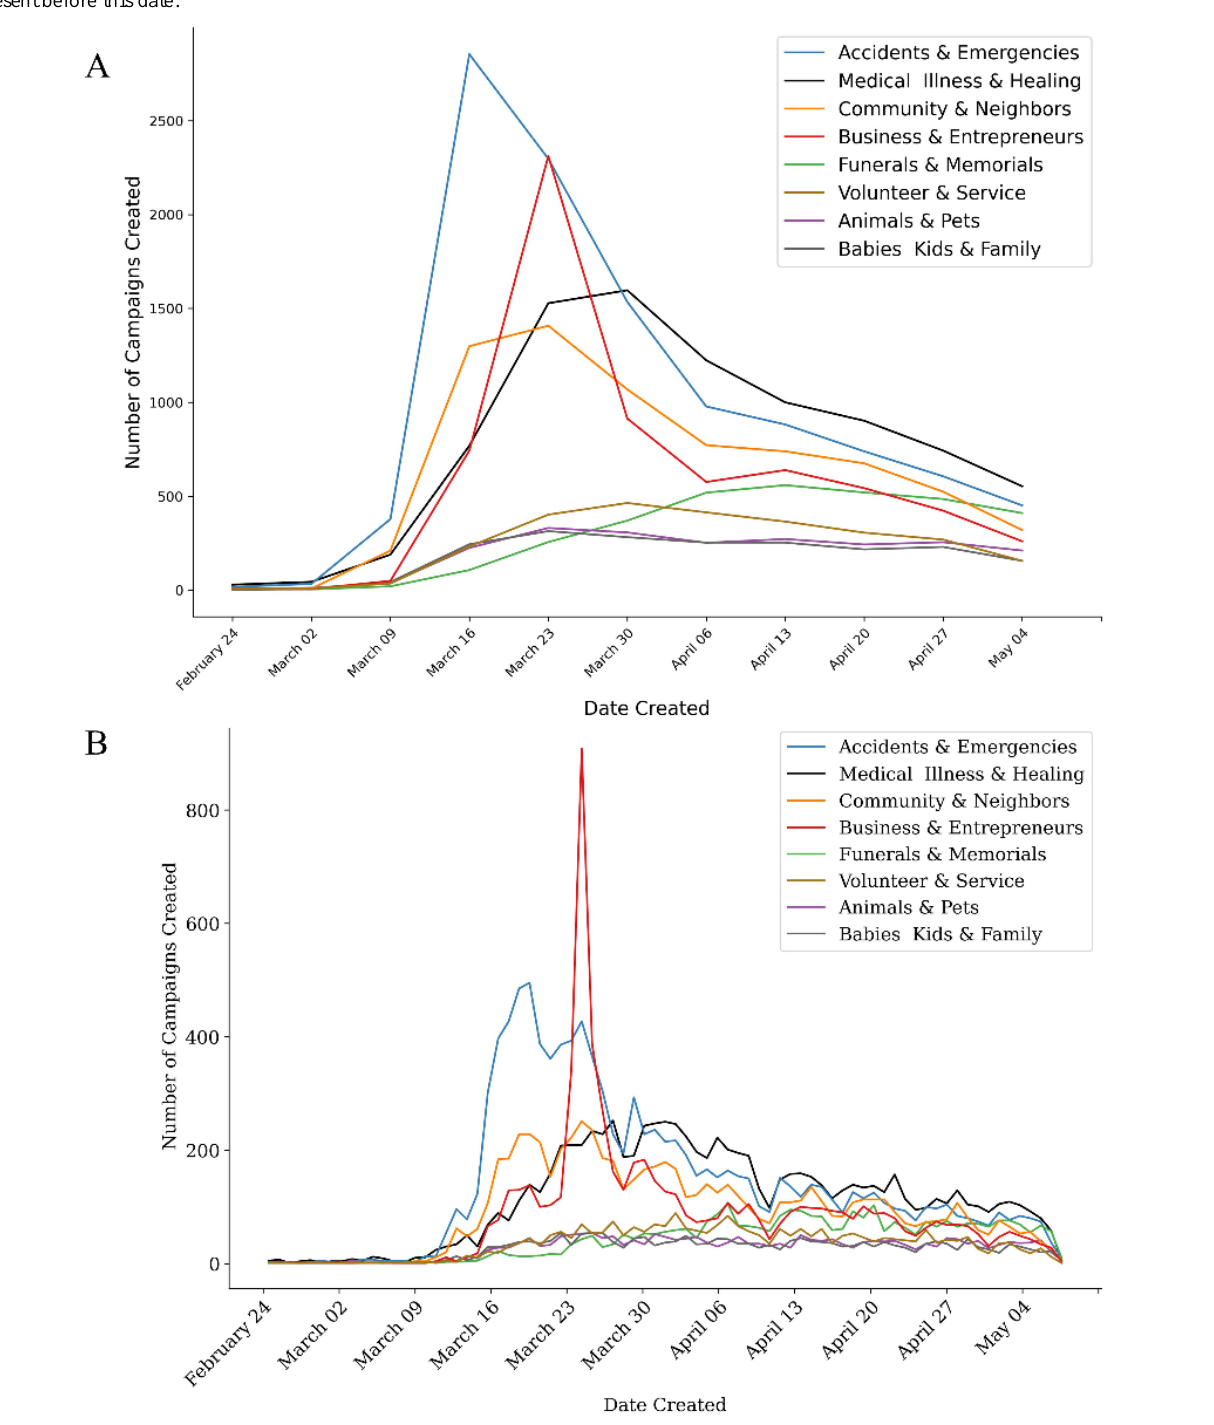
Figure 4. COVID-19–related GoFundMe campaigns per category (A) by week and (B) by day. Only the top 8 of the 20 possible categories are shown. The legend is ordered from most to least common category. Dates on the x-axis start from February 25, as few COVID-19–related campaigns were present before this